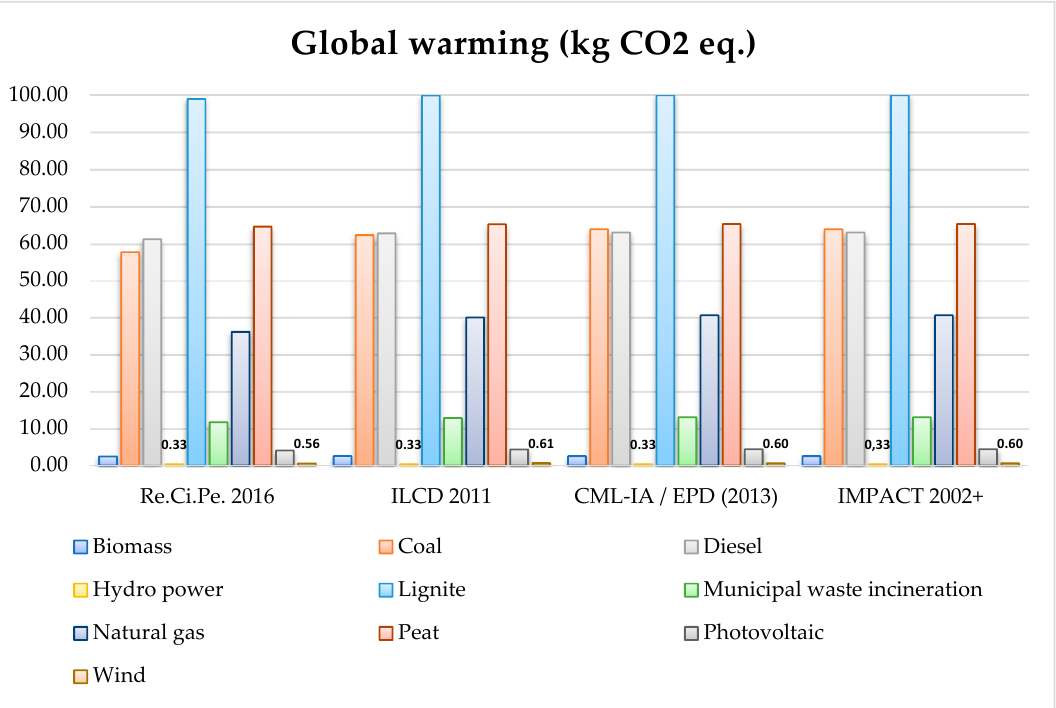
Figure 4. Comparison of global warming category by midpoint methods, expressed as a relative percentage.